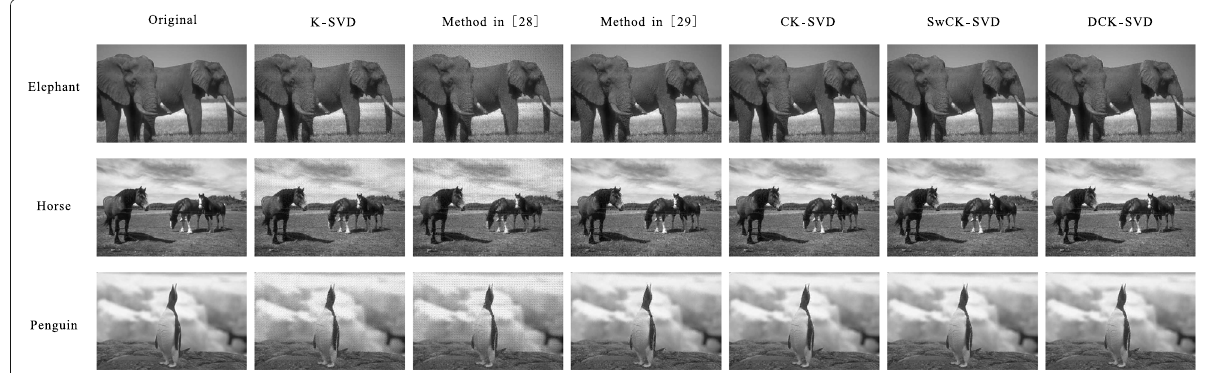
Fig. 9 Reconstructed images by using different dictionaries with the patch size of 8 × 8, m =